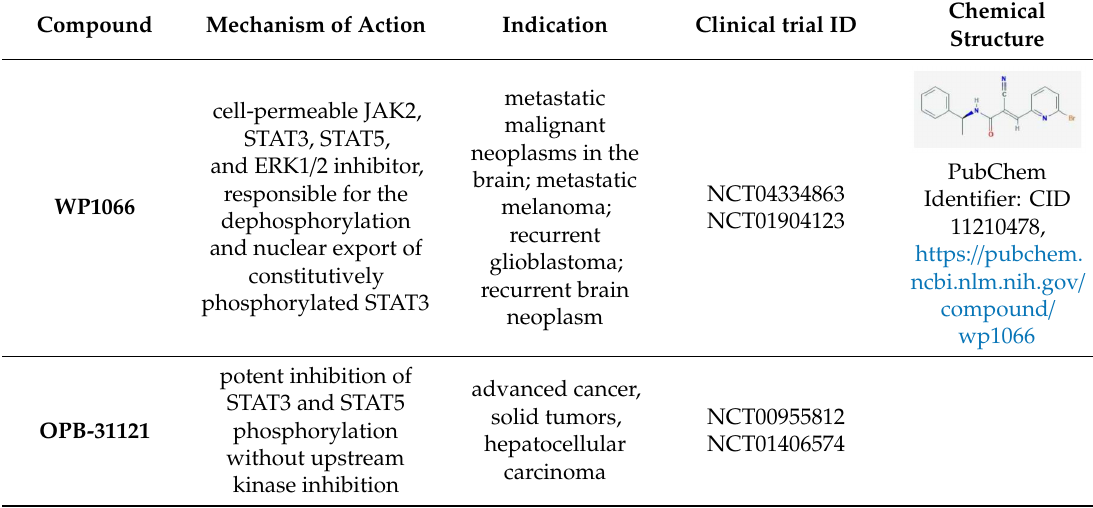
Table 2. Current clinical trials of STAT3